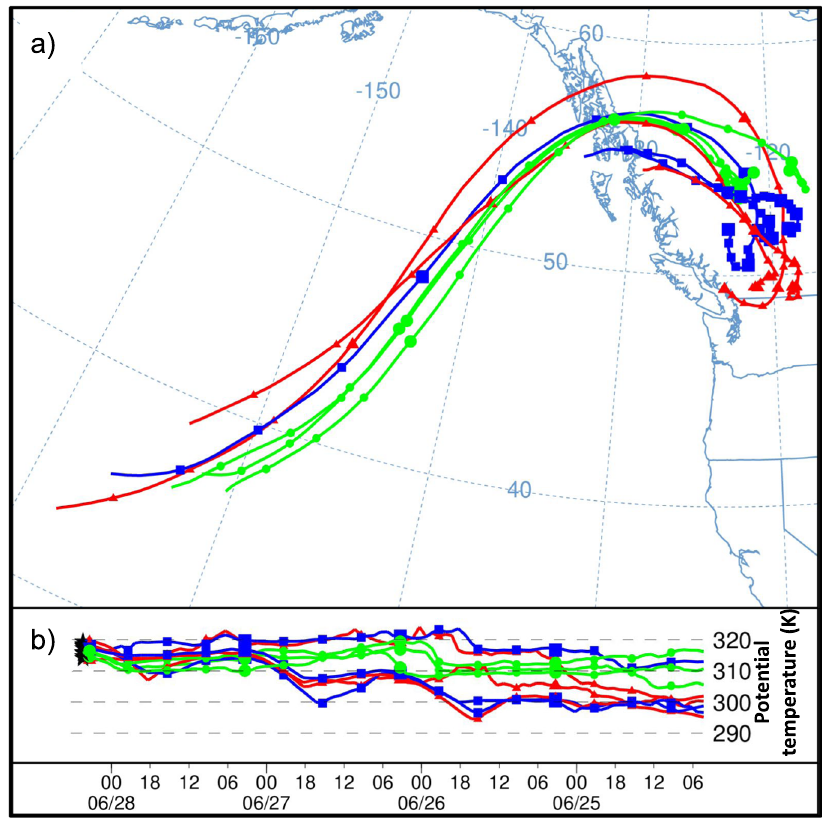
Fig. 4 | Back-trajectories for Near-surface Heatwave Air. a Nine representative four-day backward trajectories terminating at 500m above ground level (AGL) within the strongest heat anomaly (boxed area in Fig. 1a). b Potential temperature of parcels along the trajectory, time from right to left. Potential temperature